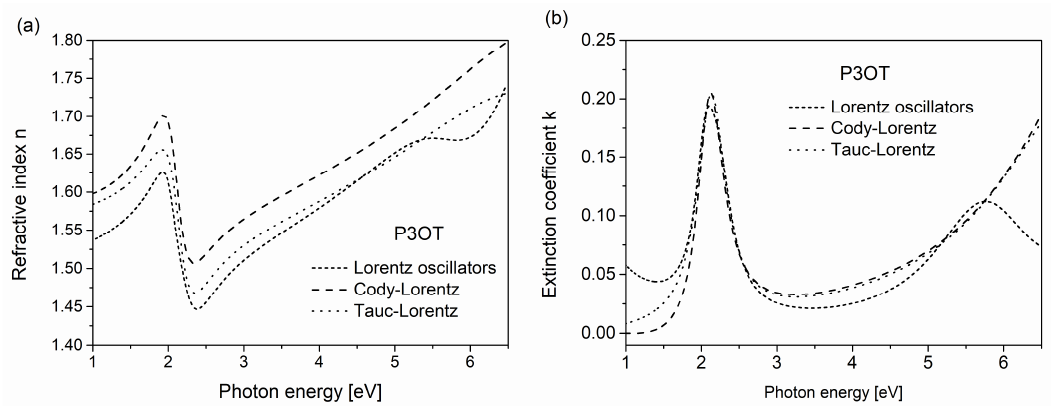
Figure 9. Dispersion relations of optical constant for P3OT ( a ) refractive index, ( b ) extinction coefficient.